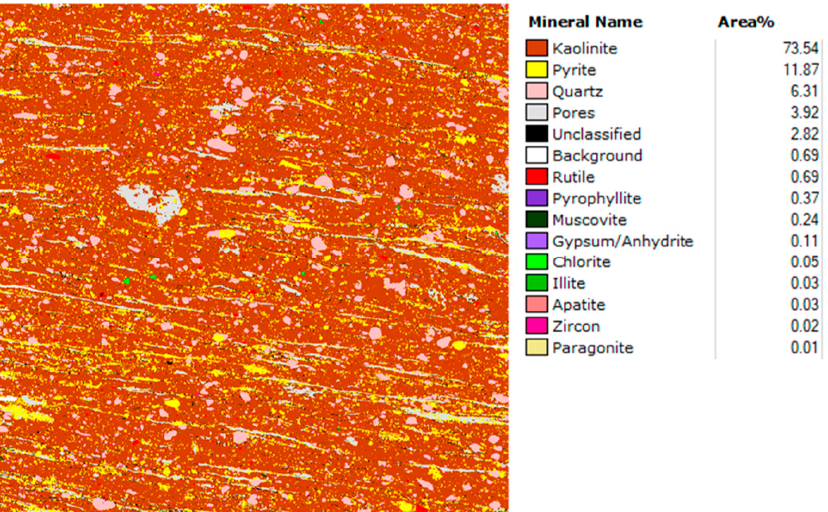
Figure 2. The mudstone mineral composition map.